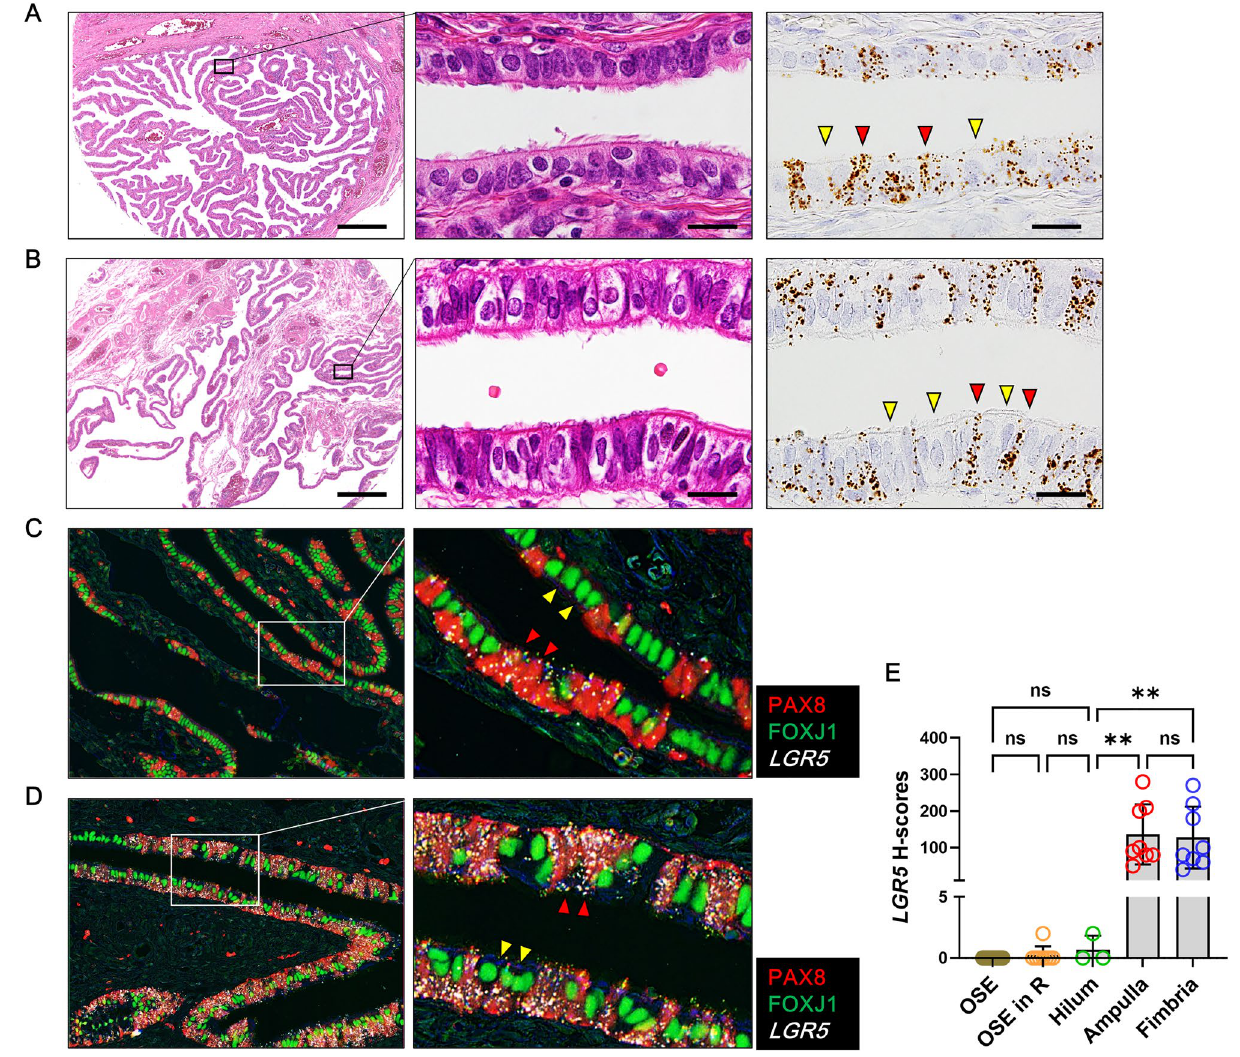
Figure 4. High levels of LGR5 expression in the fallopian tubes. ( A ) Ampulla of the fallopian tube harbors two types of epithelial cells: ciliated cells (indicated by yellow arrowheads) and secretory cells (indicated by red arrowheads). Strong LGR5 expression seems to be confined to secretory cells. Scale bar, 0.5 mm (left panel) and 50 µm (middle and right panels). ( B ) The epithelium in the fimbria exhibits the same LGR5 expression pattern as in the ampulla. Scale bar, 0.5 mm (left panel) and 50 µm (middle and right panels). Combined in situ hybridization for LGR5 (white dots) and multiplex immunohistochemistry for PAX8 (red nuclear stain) and FOXJ1 (green nuclear stain) was performed on a ciliated cell-rich area ( C ) and on a secretory cell-rich area ( D ). PAX8-positive secretory cells display strong LGR5 expression (indicated by red arrowheads), while FOXJ1- positive ciliated cells do not express LGR5 (indicated by yellow arrowheads) . ( E ) A bar graph showing that histo-scores (H-scores) of LGR5 are much higher in fallopian tubes than in ovaries. OSE in R, ovary surface epithelium in regeneration. The data are shown as the means ± SD. ns not significant. ** P < 0.01 by Tukey’s multiple comparisons